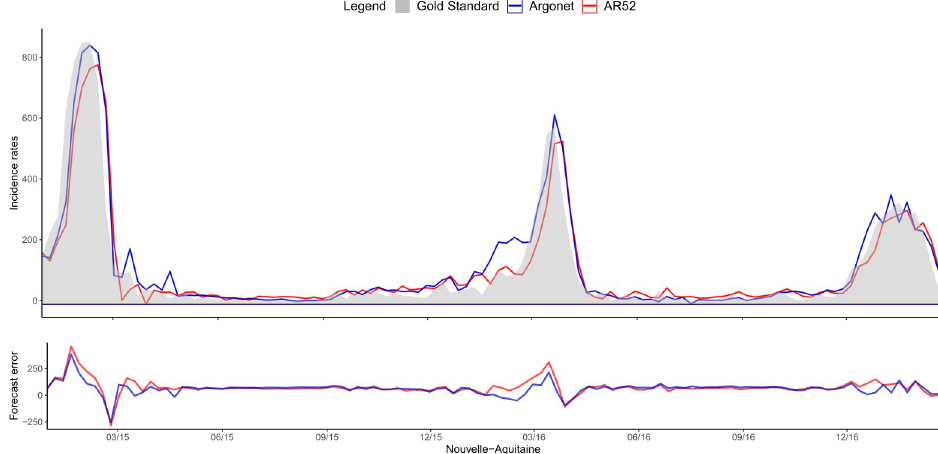
Fig 4. Two-week ahead estimate obtained with ARGONet and AR(52) models from January 2015 to March